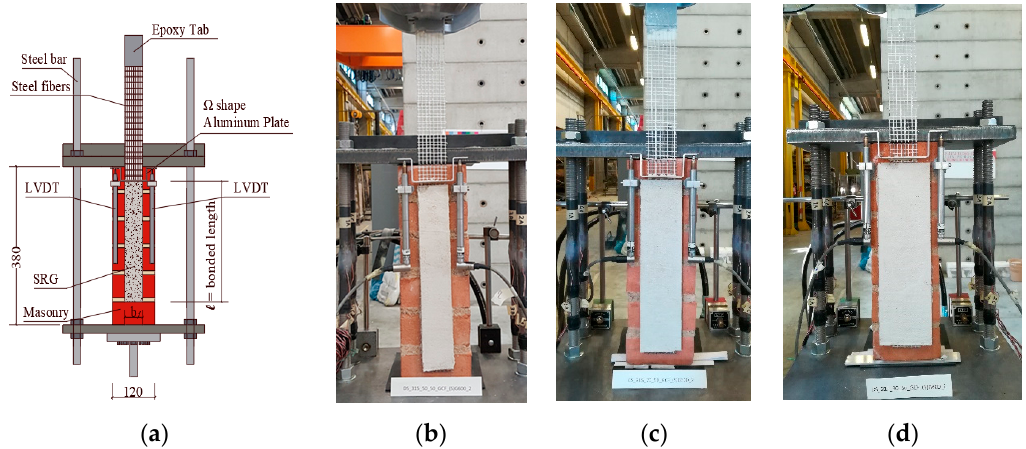
Figure 4. Single-lap direct shear set-up: ( a ) sketch of the test set-up; ( b ) photo of specimen with 50 mm; ( c ) 70 mm; and ( d ) 90 mm matrix width. Table 4. Test results of steel-reinforced grout (SRG)-concrete joints [43].